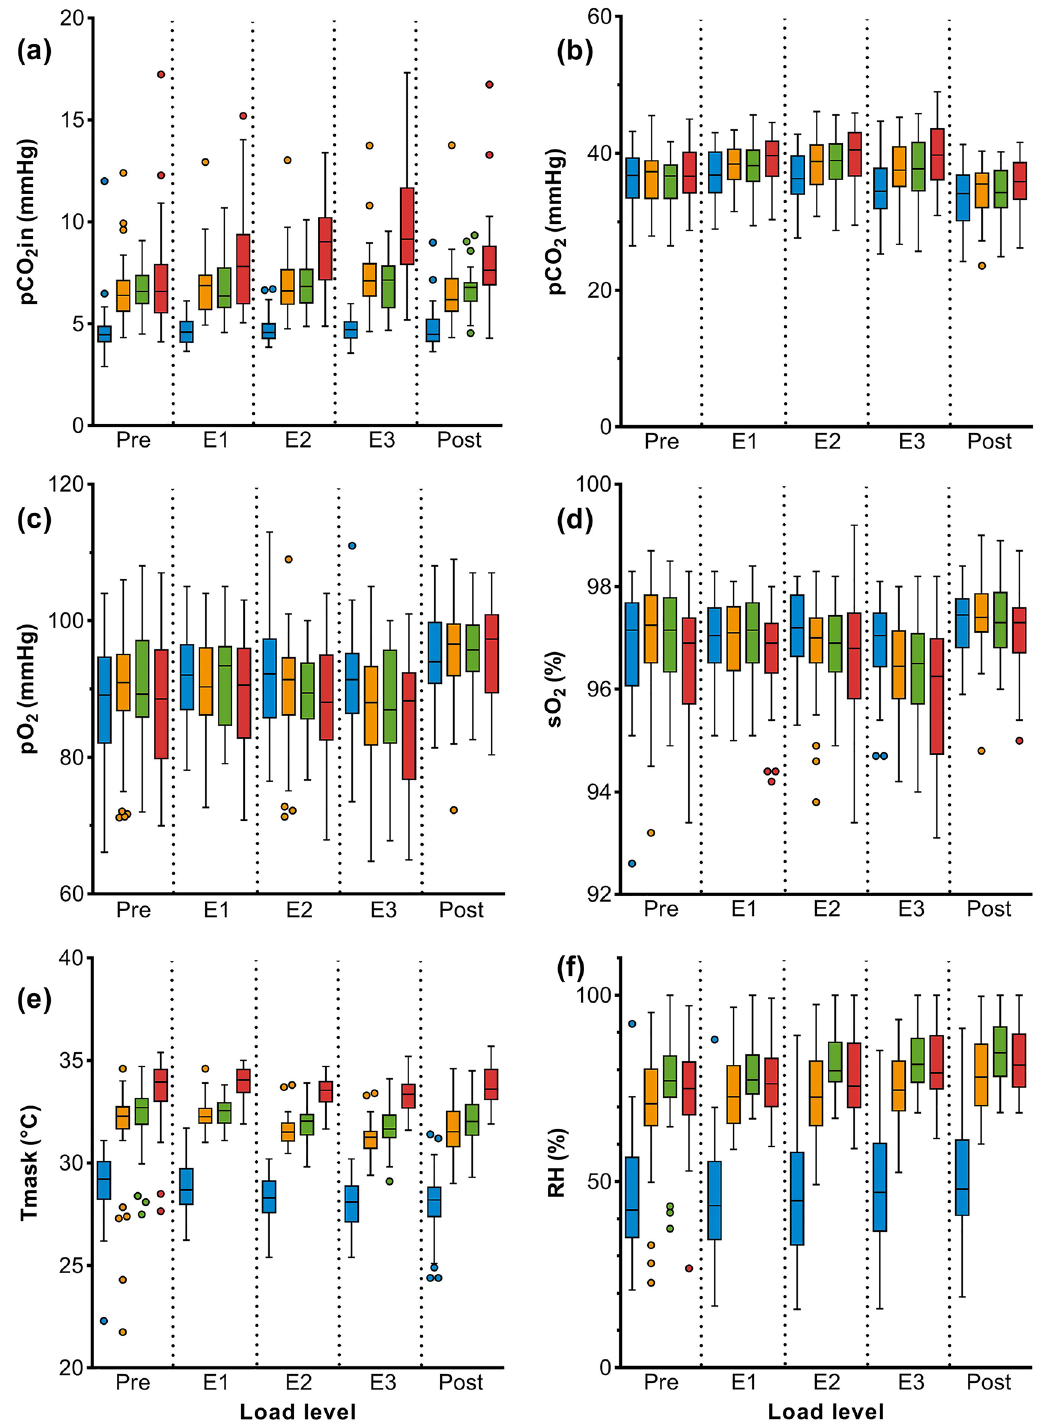
Figure 3. Ergometry measurements: Results of (a) inspiratory CO 2 behind the mask (pCO 2 in), ( b ) blood partial pressure of CO 2 (pCO 2 ); ( c ) blood partial pressure of O 2 (pO 2 ); ( d ) haemoglobin oxygen saturation (sO 2 ), ( e ) temperature behind the mask (Tmask), and ( f ) relative humidity behind the mask (RH) in 40 subjects wearing no mask (blue), surgical mask (yellow), community mask (green), and FFP2 (red). The load levels correspond to light work (pre and post), moderate (E1), heavy (E2) and very heavy work (E3). P-values are shown in Table